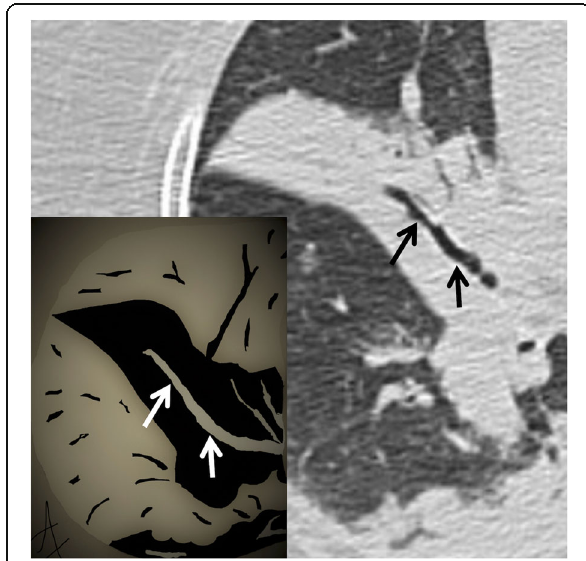
Fig. 1 Air bronchogram sign. The figure clearly shows patent bronchus (black arrows) inside a pulmonary consolidation, in a patient with pneumonia. The embedded drawing demonstrates the correspondent patent bronchus inside the consolidation (white arrows)